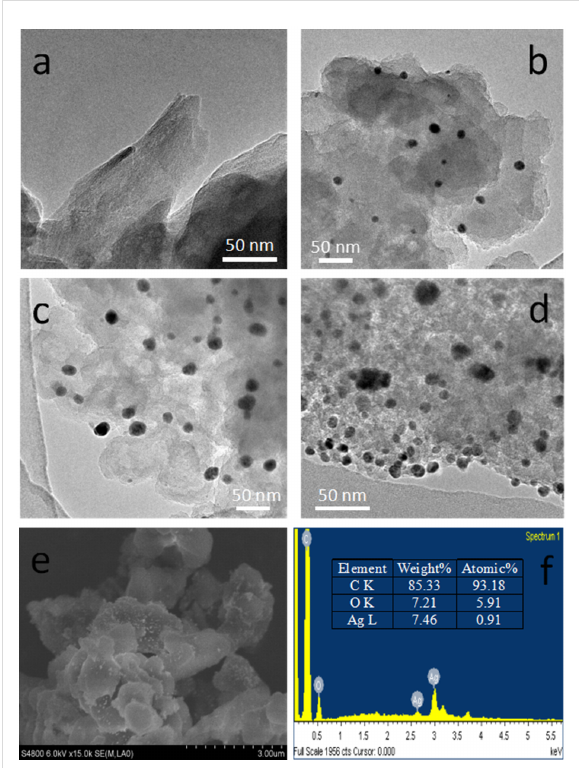
Figure 3: TEM images of the AgNPs /SugPOP-1 composite taken at different reaction times: (a) 0 h, (b) 8 h; (c) 16 h; (d) 24 h. (e) SEM image and (f) the corresponding EDX data of the AgNPs /SugPOP-1 composite obtained after reaction for 24 h.